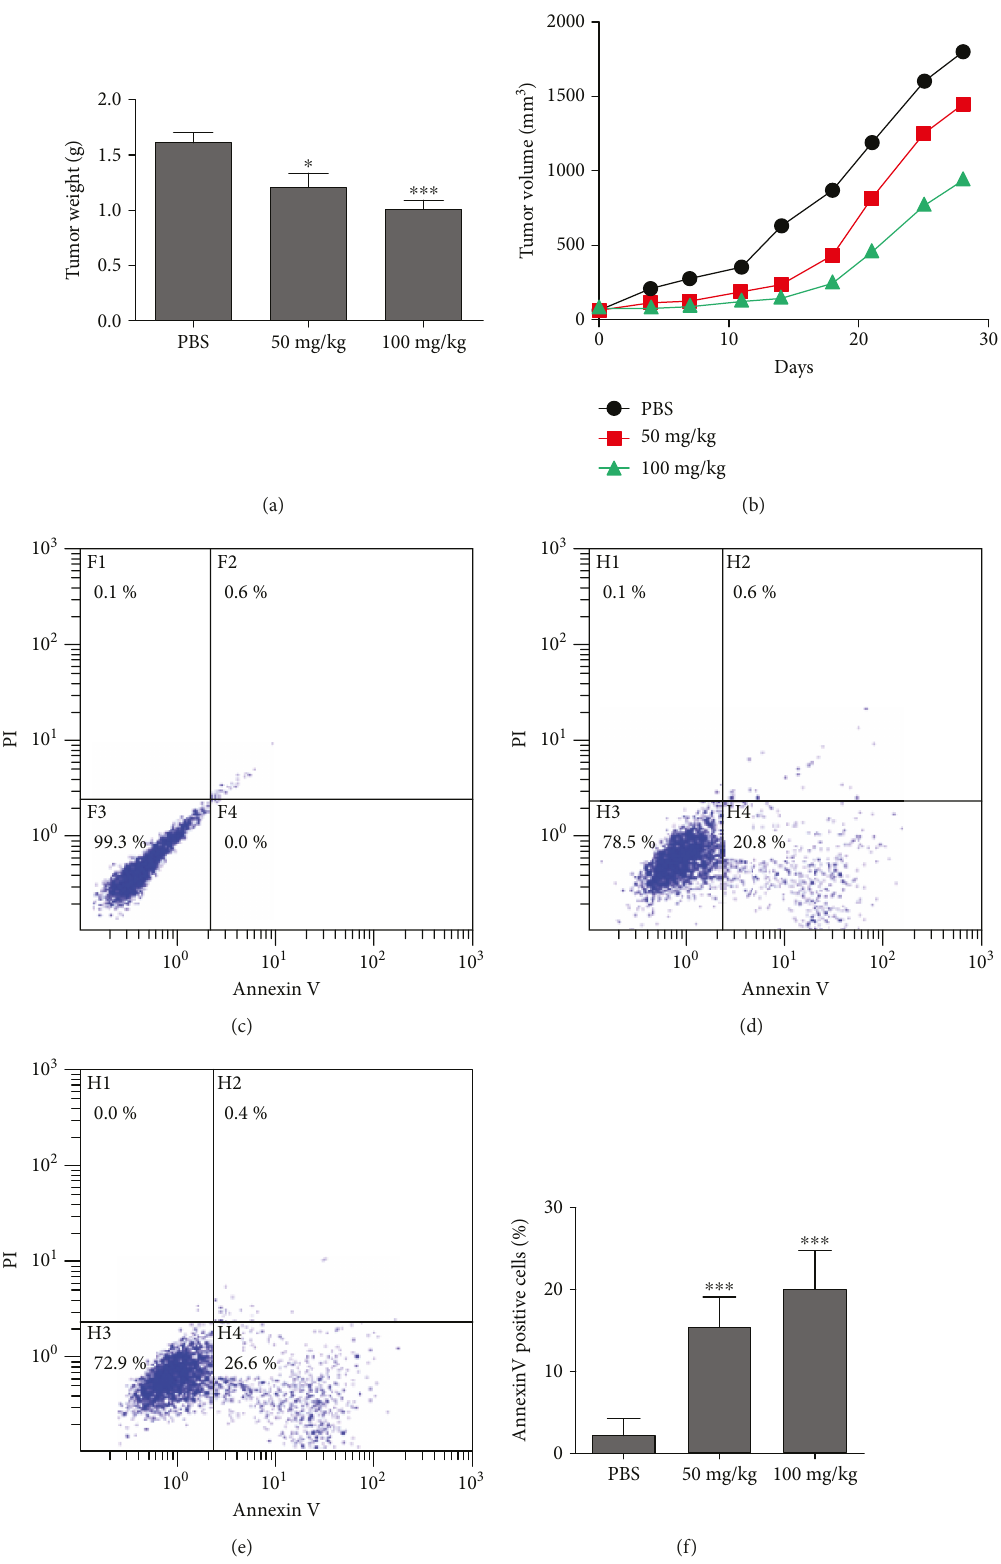
Figure 2: E ff ect on tumor weight and apoptosis induced by CPP. (a) and (b) presented the tumor weight of mice with speci fi c treatment. In (c), (d), (e), and (f), apoptotic cells were quanti fi ed by fl ow cytometry after stained with Annexin V and PI. Data were presented as mean ± SD. ∗ p < 0 05 compared with control. ∗∗ p < 0 01 compared with control. ∗∗∗ p < 0 001 compared with control. All experiments were performed